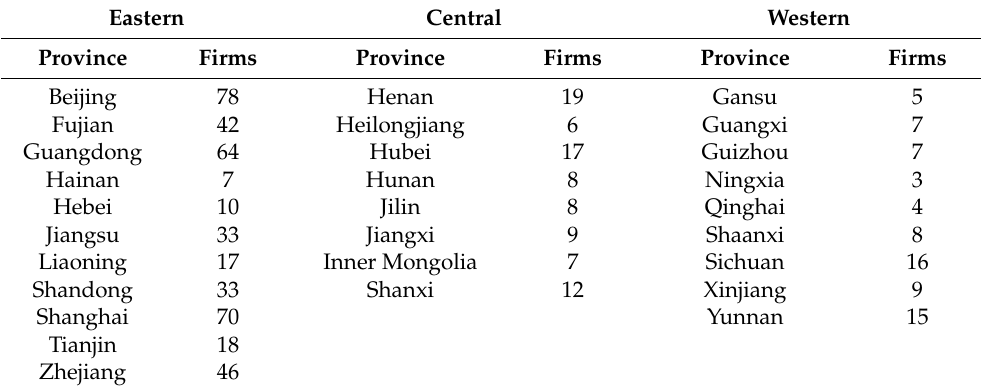
Table 1. Geographical distribution of sample